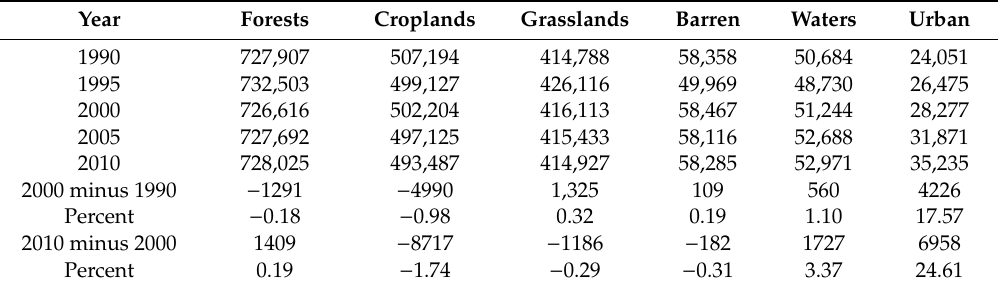
Table 4. The land-use in the Yangtze River basin (Area, unit: km 2 ; Percent, unit: %). Forests Croplands